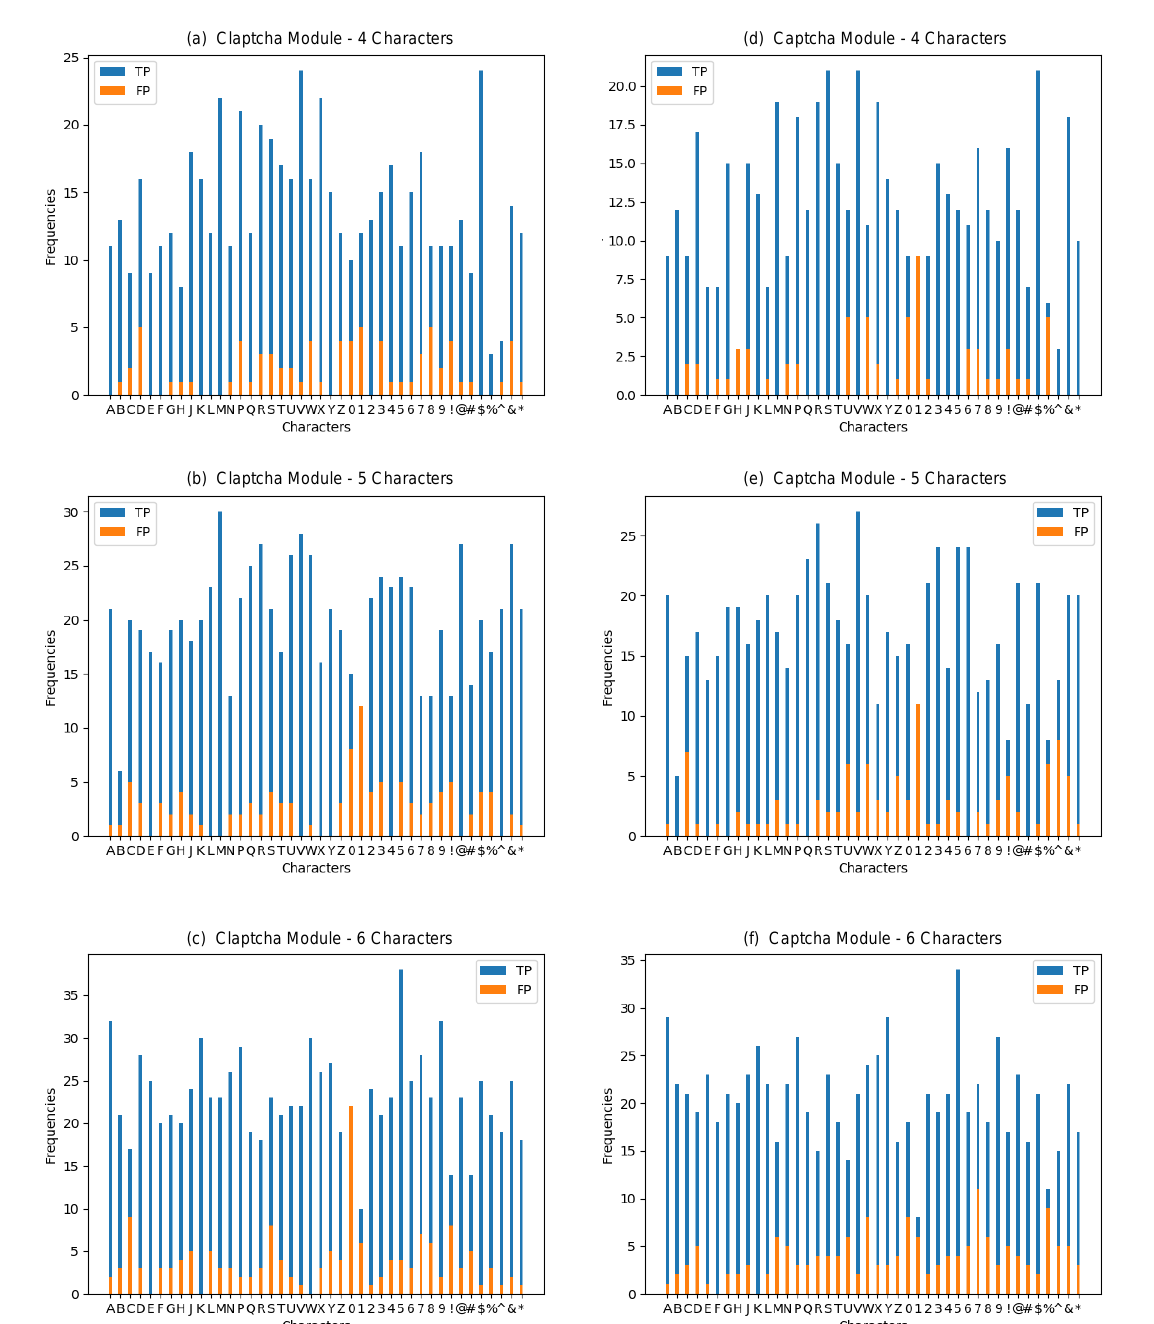
Figure 9. Statistics of True Positive and False Positive over Different Types of Testing